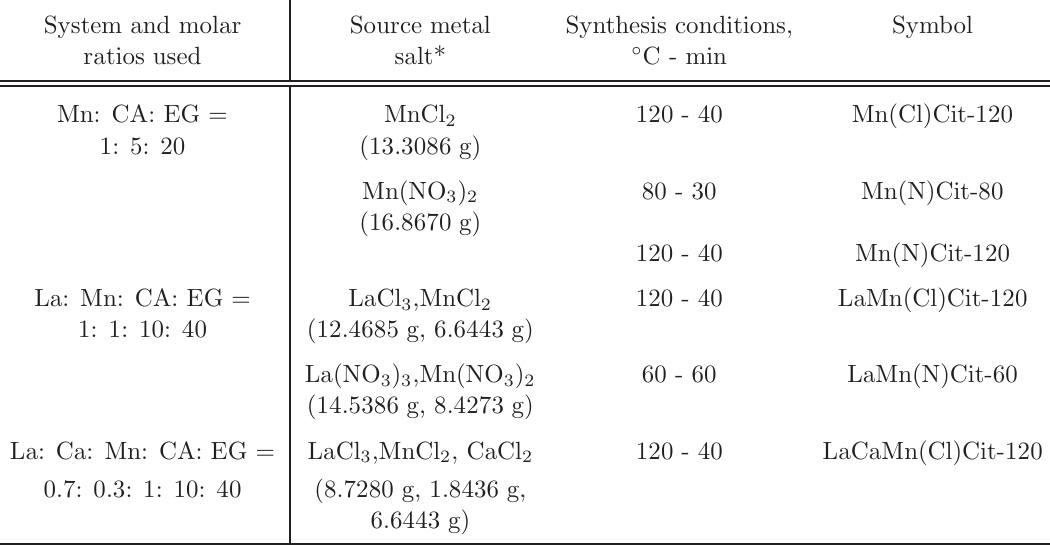
Table 1 Systems studied, synthesis conditions and symbols of the isolated